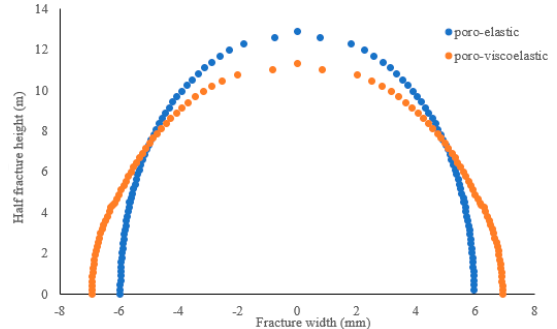
Figure 2. Fracture geometry with time.